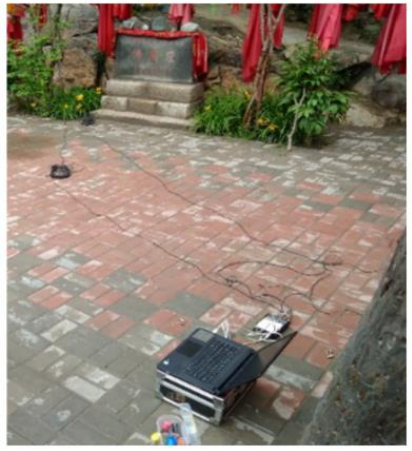
Figure 4. A measurement and monitoring point of PPV values induced by blasting.